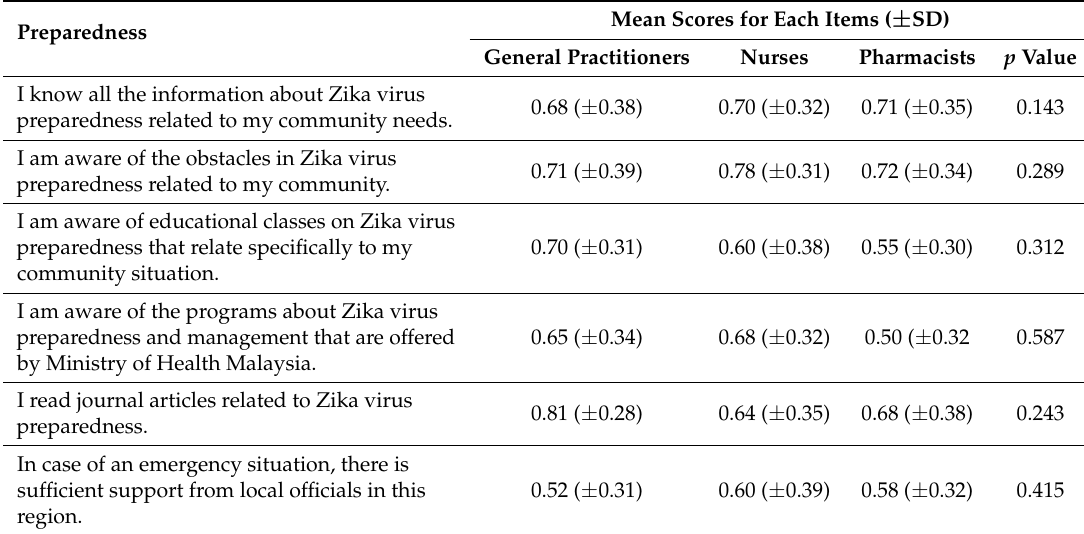
Table 2. Healthcare professionals’ preparedness for Zika